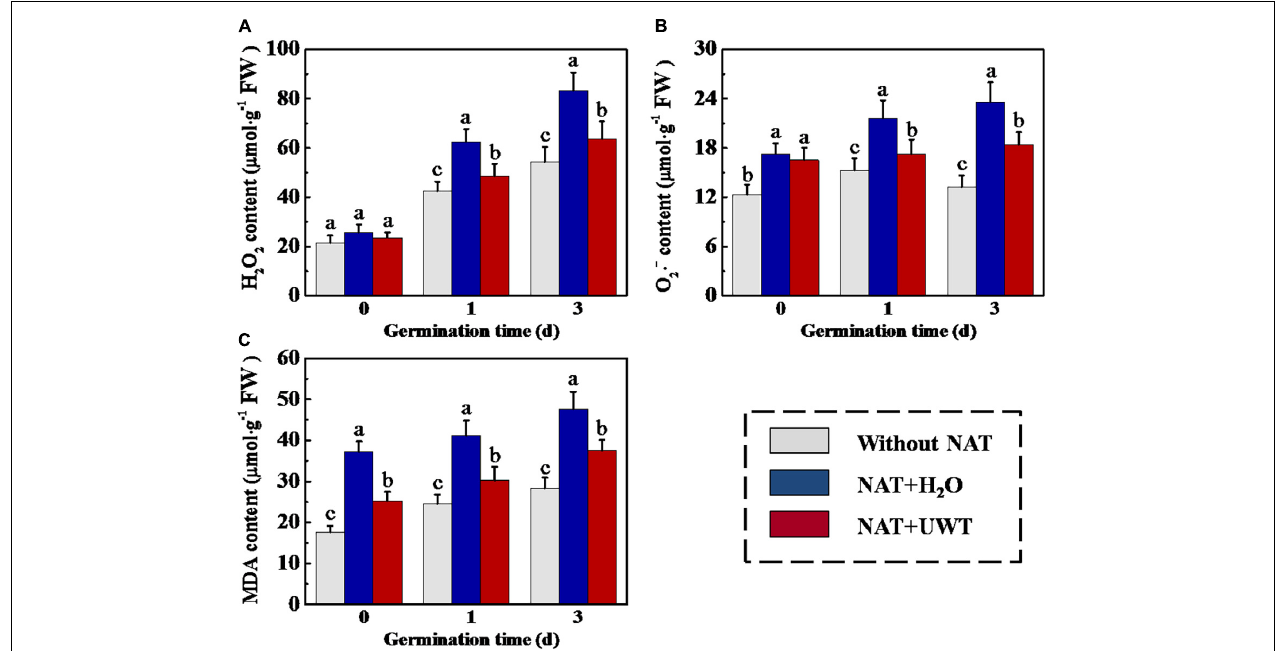
FIGURE 3 | Ultrasonic waves treatment decreased the levels of H 2 O 2 (A) , O 2 · − (B) , and MDA (C) of soybean seeds during early germination. Without NAT, fresh seeds without naturally aging treatment (NAT); NAT + H 2 O, Seeds stored for 12 months with H 2 O; NAT + UWT, NAT seeds with ultrasonic waves treatment (UWT). H 2 O 2 , hydrogen peroxide; O 2 · − , superoxide anion; MDA, malondialdehyde; Four biological replicates for each treatment were set in quantification of H 2 O 2 , O 2 · − , and MDA. Different lowercase letters indicate significant differences between different treatments ( p < 0.05).